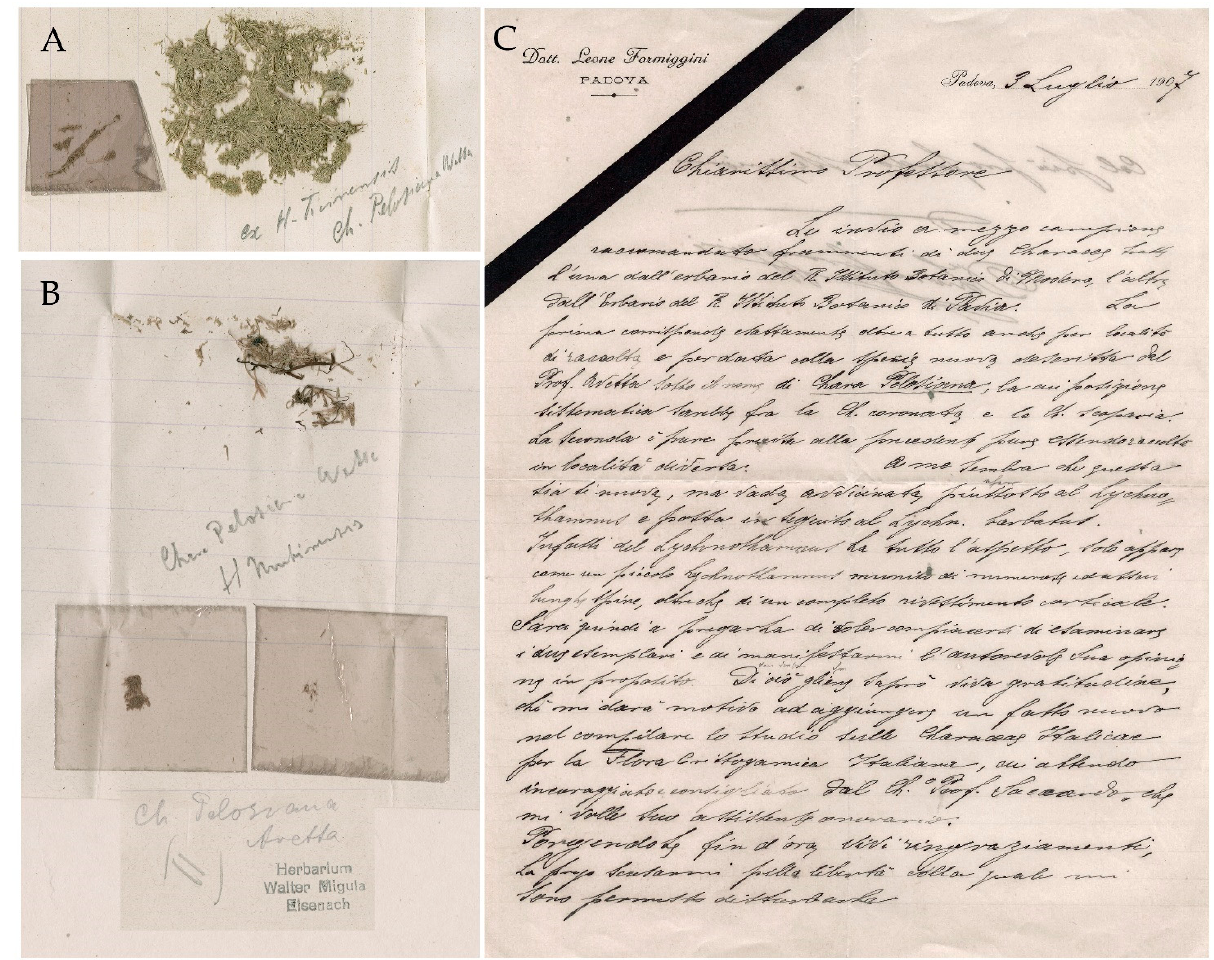
Figure 8. JE portions of Chara pelosiana sent by Formiggini to Migula in 1907. ( A ) Portions of PAV specimen with Formiggini’s handwritten notes. ( B ) Portions of MOD specimen with Formiggini’s handwritten notes (above) and Migula’s handwriting (below). ( C ) First page of Formiggini’s letter to Migula, dated 9 July 1907.